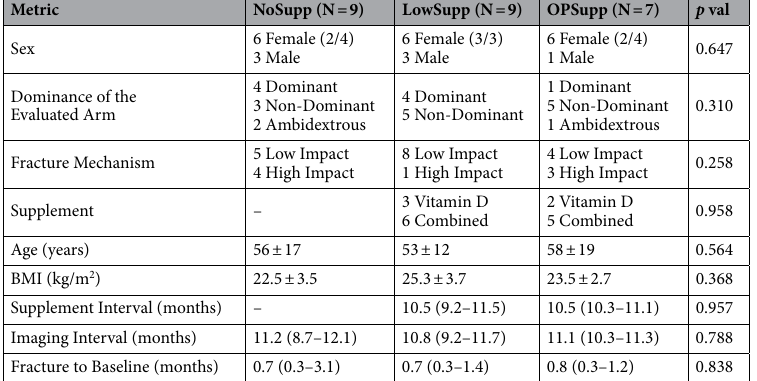
Table 1. Patient demographics for subject groups. Supplement interval represents the duration of supplementation prior to the post-intervention imaging session. Imaging interval represents the time between baseline and post-intervention imaging. Whether participants were pre- or post-menopausal is indicated after the number of females in the format of (pre/post). Data presented as either mean ± standard deviation or median (range). BMI, body mass index; N, number per group; Combined, vitamin D3 and